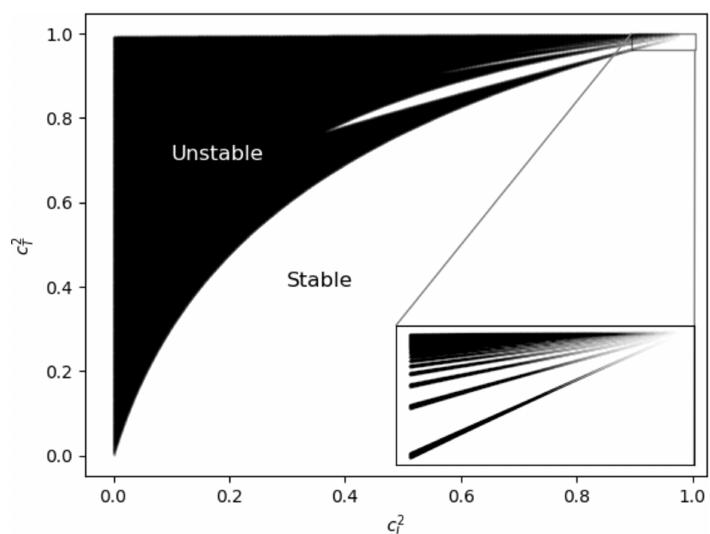
Figure 8 . The regions of instability (black) for modes between m = 2 and m = 100 , determined by finding the values of the sound speeds which give a negative discriminant. The large stable region corresponds to the region where ∆( m ) = 0 has no real roots while the thin, stable slices are caused by m being an integer. There are an infinite number of these regions as the limit c 2 approached and we show a few more stable slices by zooming into the region with 0 . 96 ≤ c 2 0 . 9 ≤ c 2 ≤ 1 . This makes it very likely that any parameter sets which admit chiral, superconducting L strings will pass through stable